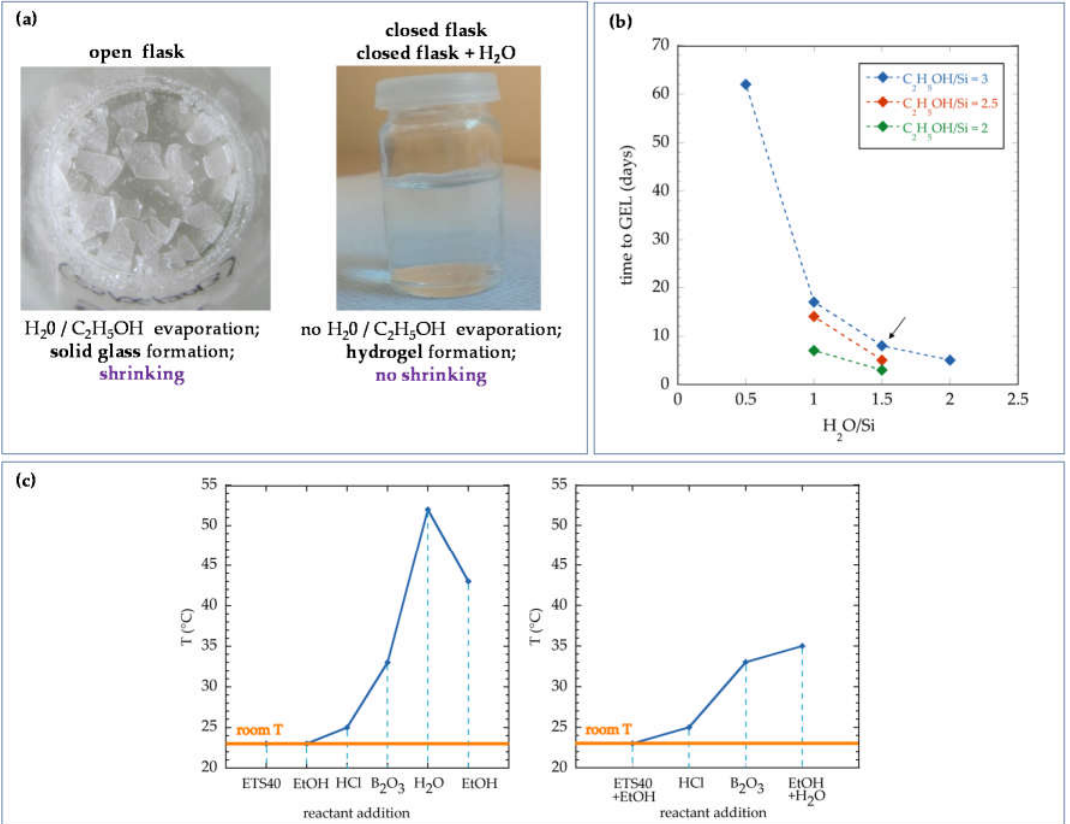
Figure 4. ( a ) Drying tests results (controlling solgel applicability); ( b ) time to form gel (in days) versus the H 2 O/Si ratio used in the solgel synthesis for solgels produced with an EtOH/Si ratio of 3 (in blue), 2.5 (in orange) and 2 (in green); ( c ) monitoring of temperature during the addition of reactants to the bulk solution in the solgel synthesis. Note that the black arrow in ( b ) indicates the best solgel in terms of gel formation time, viscosity and reactivity selected to perform the permeability tests.